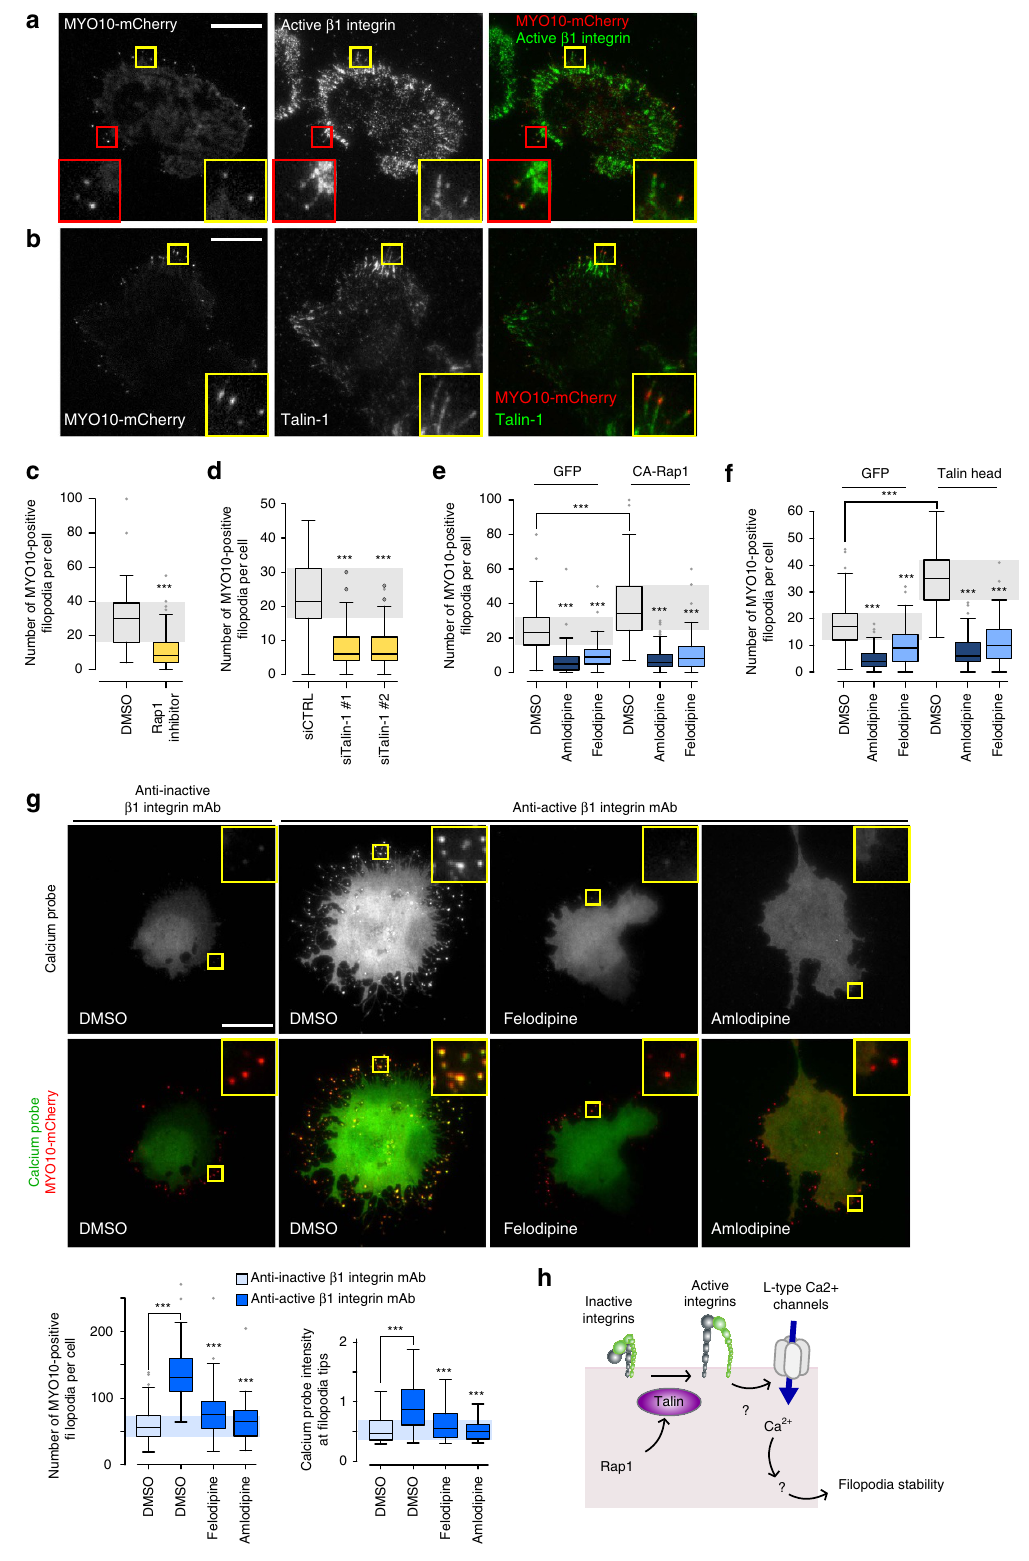
NATURE COMMUNICATIONS|7:13297|DOI: